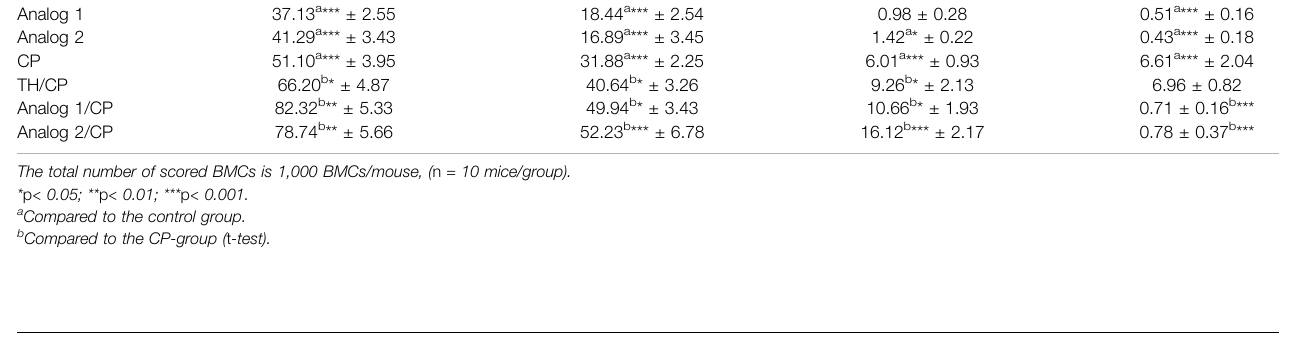
TABLE 3 | Analysis of multinucleated BMCs in absence of micronuclei: BMCs from different mice groups have been investigated after 24 h from administration of TH and analogs in absence and presence of CP.